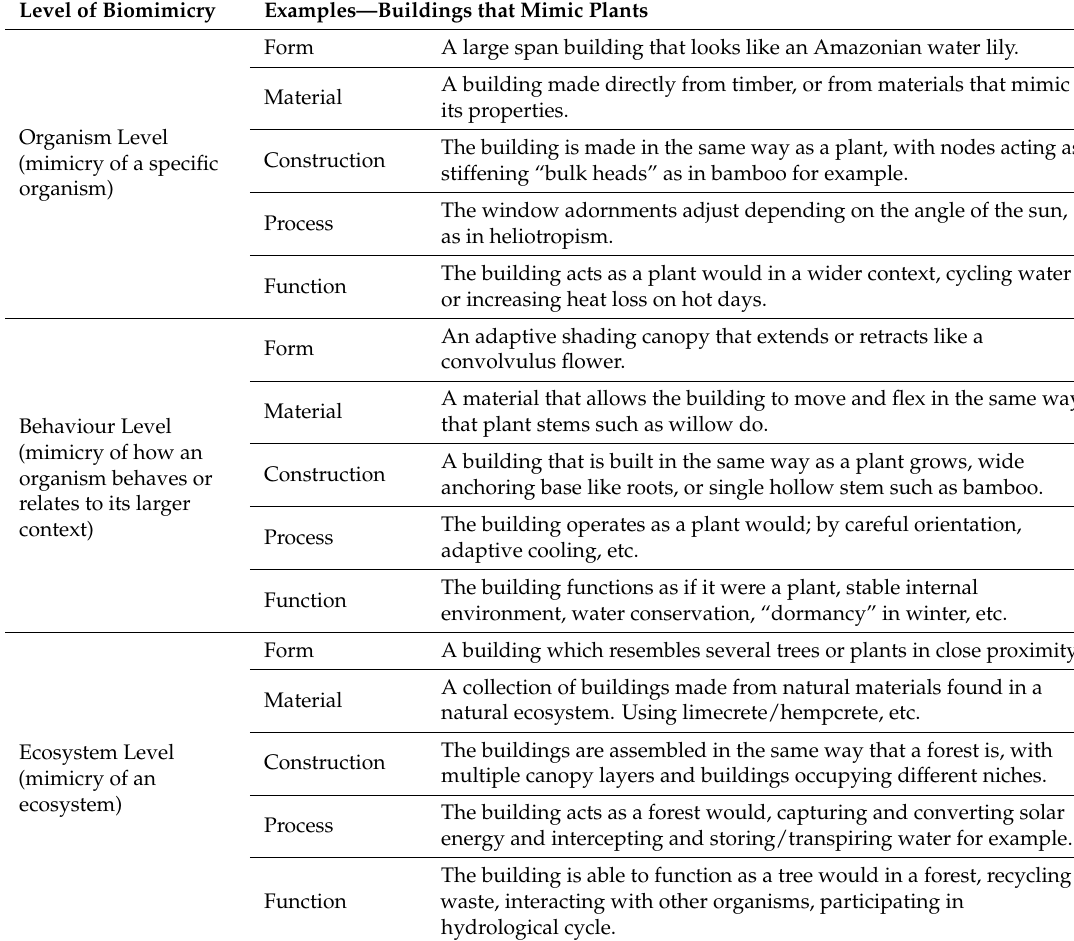
Table 1. A framework for the application of biomimicry (adapted with permission from Pedersen Zari, 2007